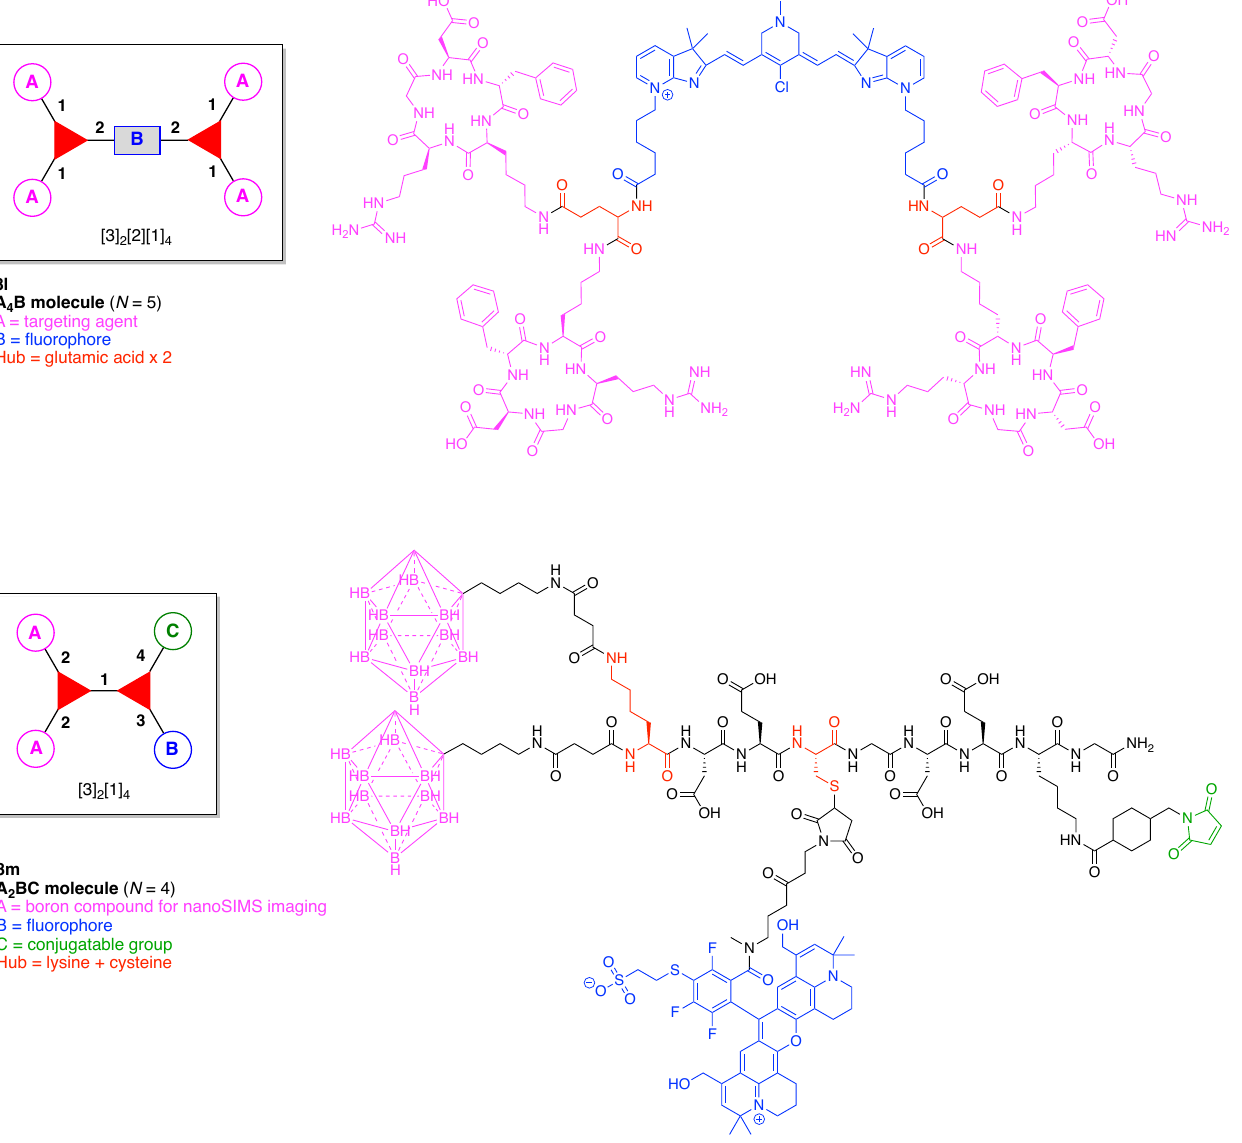
Figure 29. Two examples each with two amino acid hubs. A photoaffinity multivalent glycoprobe ( 8n ) was developed for the covalent capture of labile protein complexes via carbohydrate-mediated interactions (Figure 30) [172]. The glycoprobe contains two hubs, a single Glu and a 4-arm carbon unit, and three functional components: (A) galactose as a targeting agent for affinity binding to a lectin; (B) (trifluo- romethyl)phenyldiazirine as a PAL agent, and (C) 3-fluorocyclooctyne as a conjugatable group for late-stage functionalization by strain-promoted [3 + 2]-azide–alkyne cycloaddi- tion [173] (SPAAC). This construct ( 8n ) has composition A 3 BC and architecture [4][3][1] 5 . An amphiphilic biotin conjugate ( 8o ) was developed for use in a targeted, triggered liposomal delivery system (Figure 30) [174]. The conjugate is comprised of two hubs, a single Ser and a three-arm carbon unit, and five functional components: (A) an octadecyl group; (B) a dansyl fluorophore; (C) a biotin tag; (D) a disulfide linker as a reduction- cleavable group, and (E) a quaternary ammonium salt as a water-solubilizing linker. This construct ( 8o ) has composition A 2 BCDE and architecture [3] 2 [2] 2 [1] 4 .